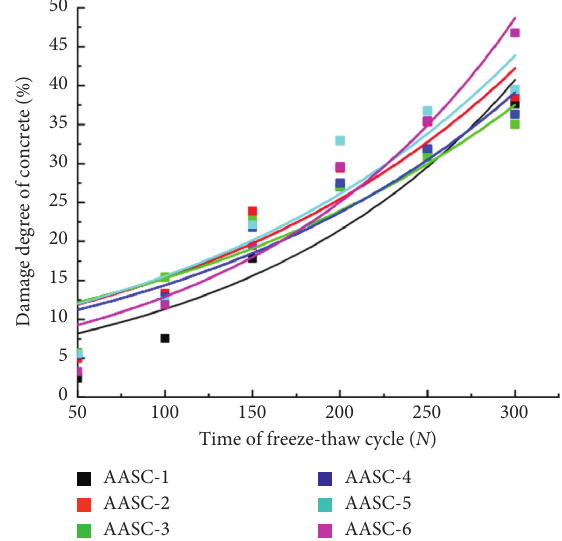
Figure 14: Compressive strength accumulative damage expo- nential function